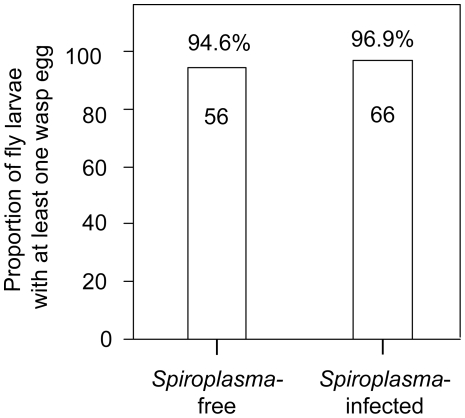
Wasp oviposition frequency in Spiroplasma-free and Spiroplasma-infected Drosophila hydei larvae.Proportion of fly larvae that had at least one wasp egg. Numbers above columns  =  exact proportion. Numbers in columns  =  number of fly larvae examined.